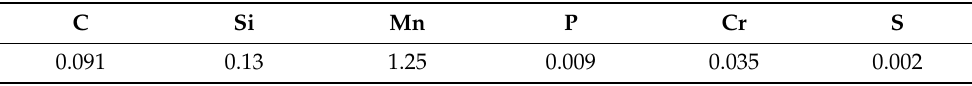
Table 1. Chemical composition of the tested steel